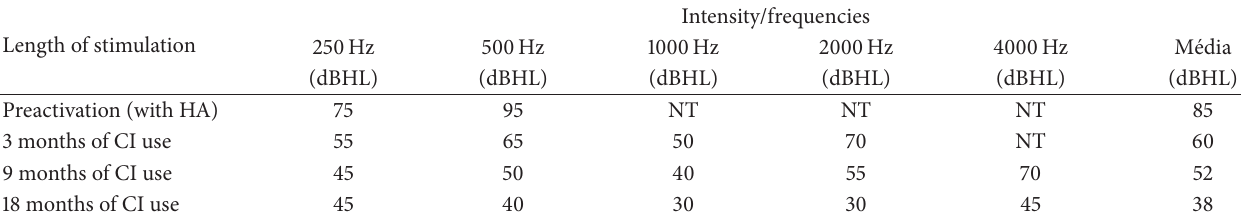
Table 1: Hearing thresholds in free field of the child with hearing loss with the electronic device.